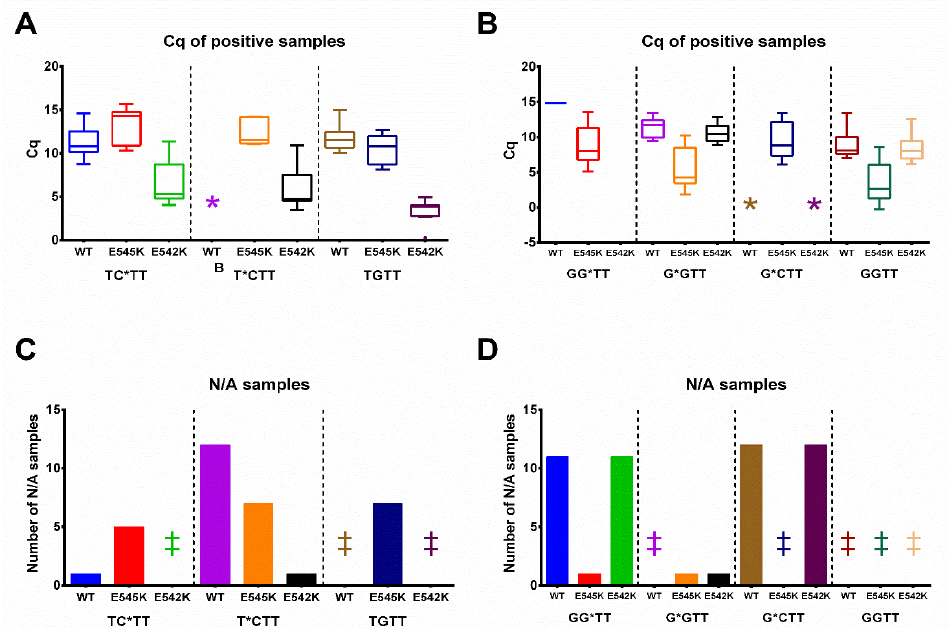
Figure 4. PIK3CA E542K ( A , C ) and E545K ( B , D ) mutation status analysis in FFPE samples. Three types of samples according to dPCR data were used: (1) WT; (2) E542K positive; (3) E545K positive. The clinical samples are coded according to ddPCR mutation status analysis. The mutation percent for the E542K positive samples (left, for T C *T T , T* C T T , and T G T T primers) are indicated as 0.56%, 3.72%, 5.76%, 6.21%, 7.03%, 13.53%, 20.91%. The mutation percent for the E542K positive samples (right, for G G *T T , G* G T T , G*CT T , and G G T T primers) are indicated as 0.56%, 3.72%, 5.76%, 6.21%, 7.03%, 13.53%, 20.91%. ( A , B ). A Tukey plot of ∆∆ Cq values from samples with a positive amplification signal. The box always extends from the 25th to the 75th percentiles, and whiskers represent a 1.5-fold interquartile range. The y-axis marks ∆∆ Cq values: the difference between ∆ Cq for 1% positive mutation control and the ∆ Cq value for each sample. The x-axis represents the type of sample (WT, E542K, E545K-positive) and the AS primer. * marks cases with no positive amplification signal and retrieved Cq values. ( C , D ). The number of samples with negative amplification results and no Cq values (N/A). The y-axis marks the number of negative samples; the x-axis represents the type of sample (WT, E542K, E545K-positive) and the AS primer. ‡ marks cases with no negative samp les. Table 5. Validation of AS primers on DNA samples from FFPE.